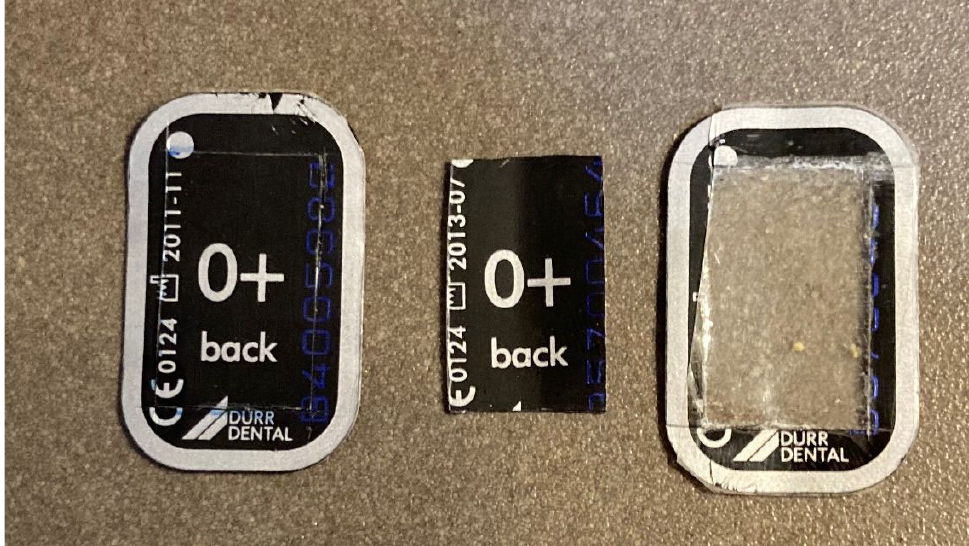
Figure 2. X ‐ ray plate number 0+ untrimmed and trimmed. Figure 2. X-ray plate number 0+ untrimmed and